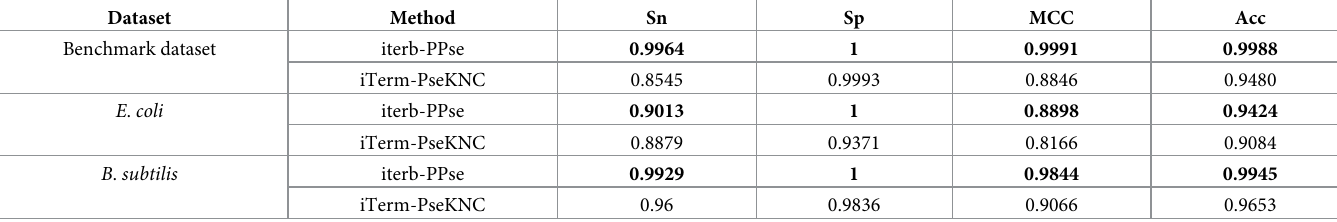
Table 7. Comparison of “iTerm-PseKNC” and “iterb-PPse”.